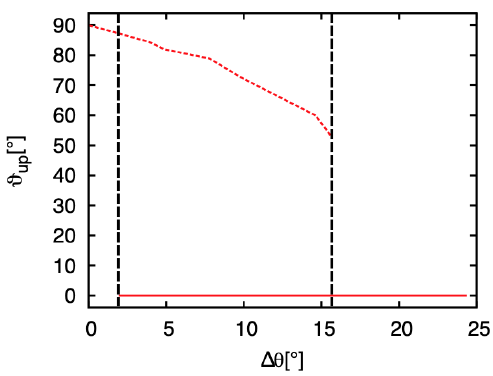
Figure 3. Final orientation of a Janus particle for m = 1.5. A tilted (red dashed line) and an upright (red solid line) orientation of the particle are shown depending on the Janus parameter ∆ θ . The vertical dashed lines divide the range of ∆ θ into three regions. In the left region, it can be concluded from the simulation results that the tilted orientation is the global minimum. In the right region, the upright orientation is the only one which is found. In the central region, both tilted and upright orientations are found in the simulation results. It cannot be seen which one corresponds to the energetic